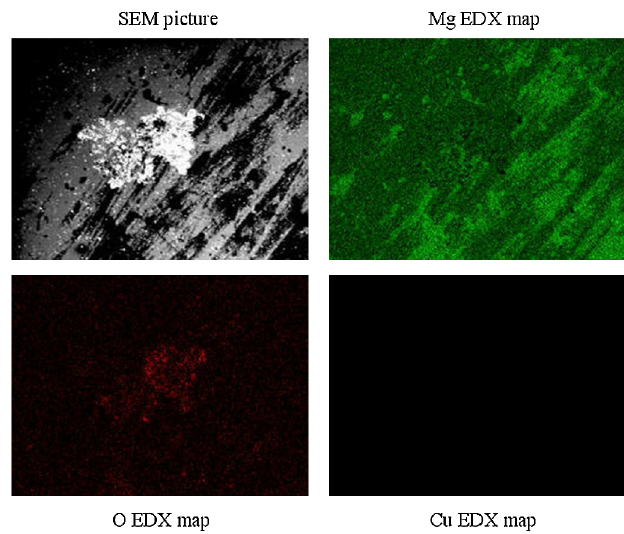
FIG. 9. EDX maps of the Mg film surrounding a clearly visible damaged area.